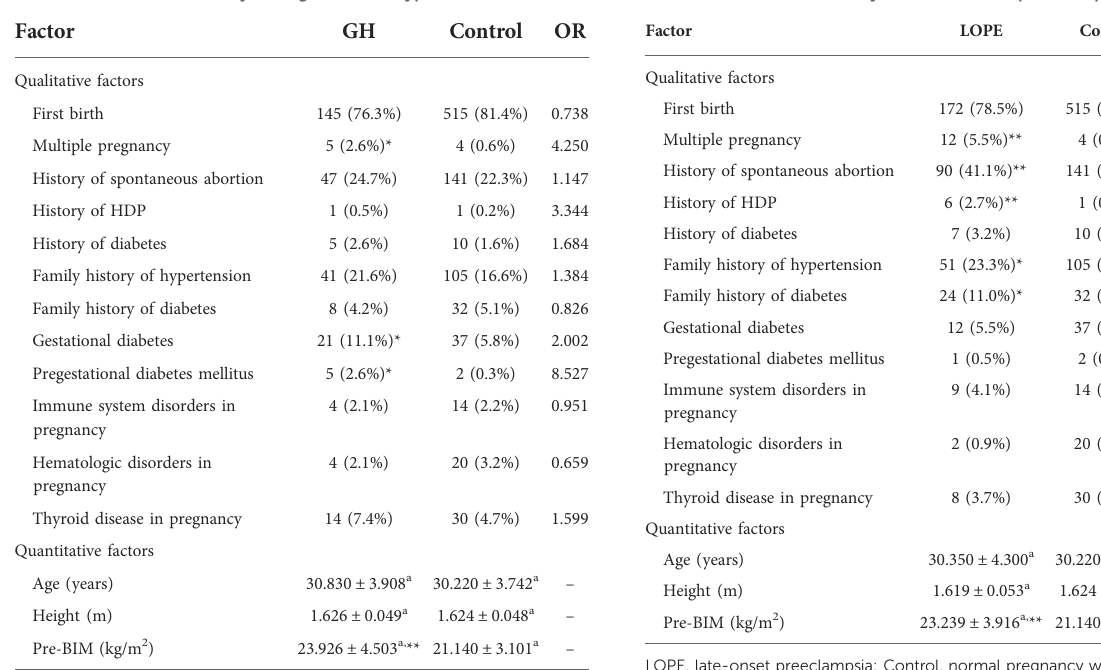
TABLE 4 Static factors analysis of gestational hypertension. TABLE 6 Static factors analysis of late-onset preeclampsia.